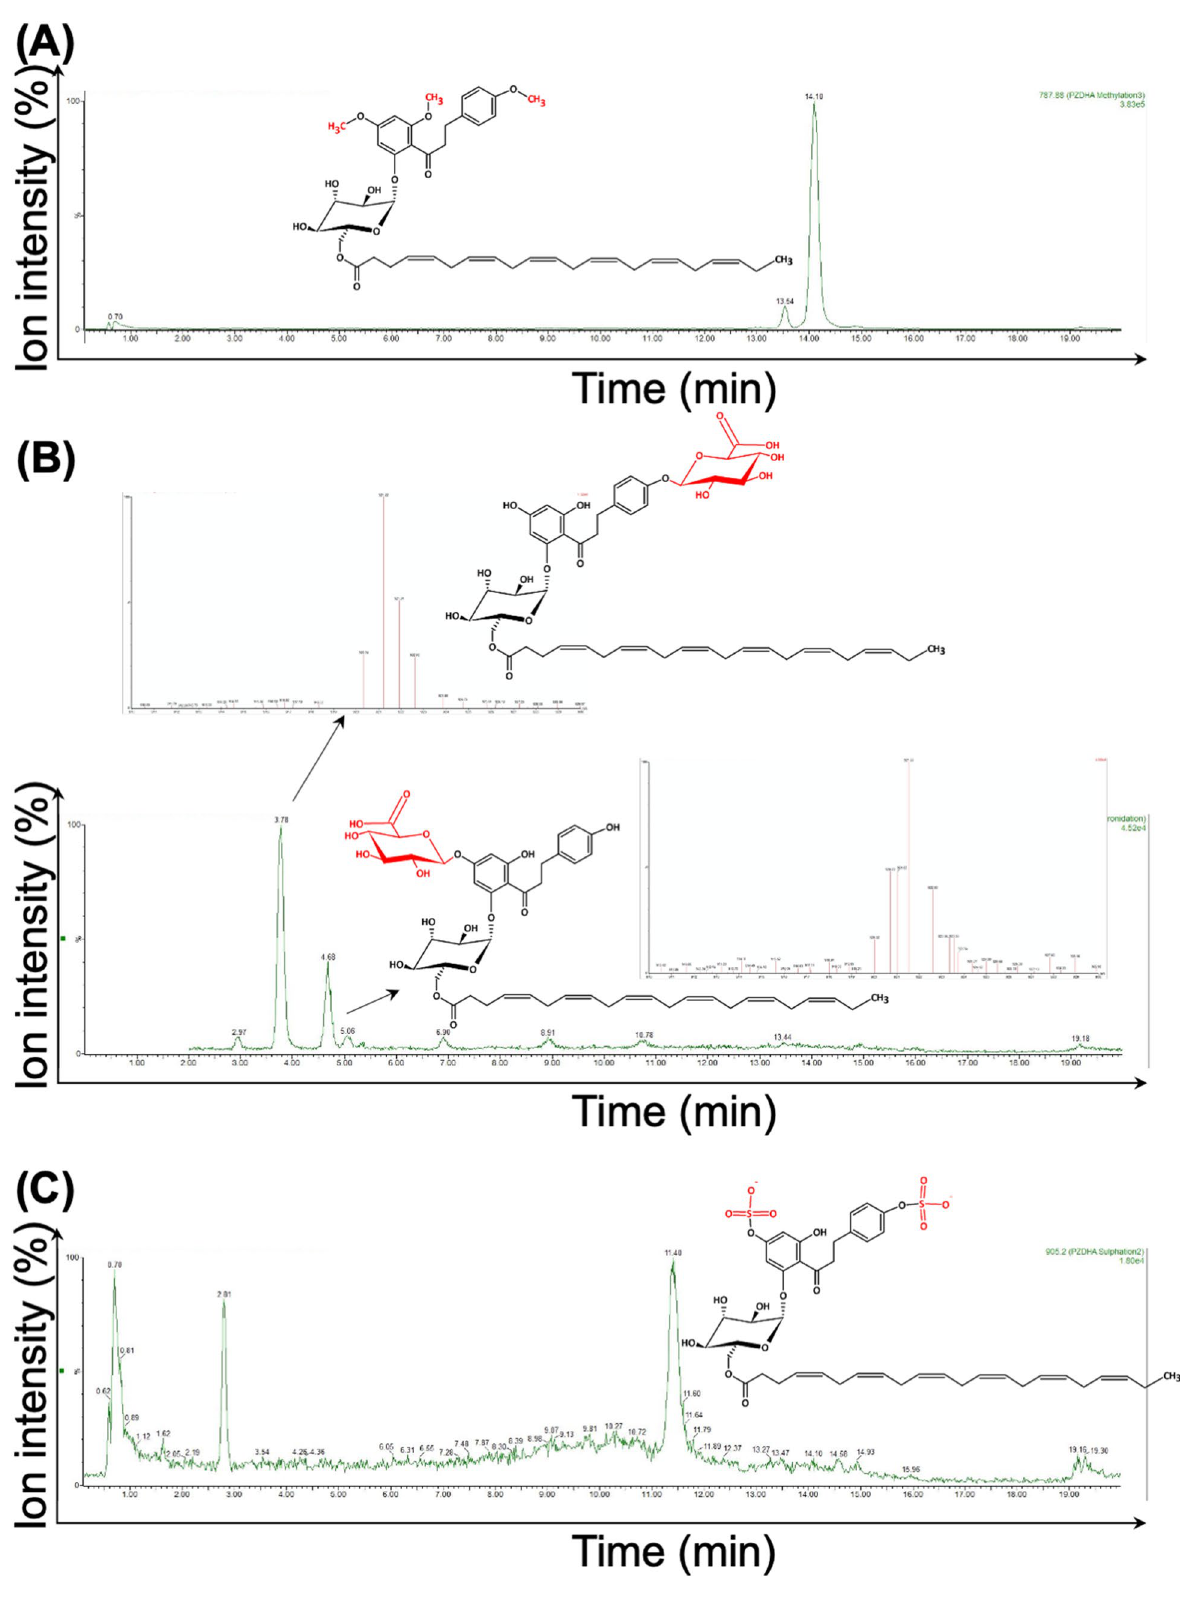
Figure 3. PZ-DHA undergoes phase II metabolism in the presence of freshly prepared mouse liver microsomes. PZ-DHA (1.1 µM) was incubated with S -(5 ′ -adenosyl)- L -methionine chloride dihydrochloride (1 mM), glucuronic acid (2 mM) and alamethicin (25 µg/mL) and adenosine 3 ′ -phosphate 5 ′ -phosphosulfate lithium salt, hydrate (0.5 mM) in the presence of mouse liver microsomal enzymes (3 mg/mL) at 37 °C for 1 h. (A) Tri-methylated-PZ-DHA (4,4 ′ ,6 ′ -tri- O -methyl-phloridzin docosahexaenoate) (MW = 788.88 g/mol), (B) phloridzin docosahexaenoate-4- O -glucuronide (MW = 923.02 g/mol) and phloridzin docosahexaenoate-4 ′ - O -glucuronide (MW = 923.02 g/mol), and (C) sulfated-PZ-DHA (phloridzin docosahexaenoate-4,4 ′ -di- O -sulphide) metabolite (MW = 906.20 g/mol) were